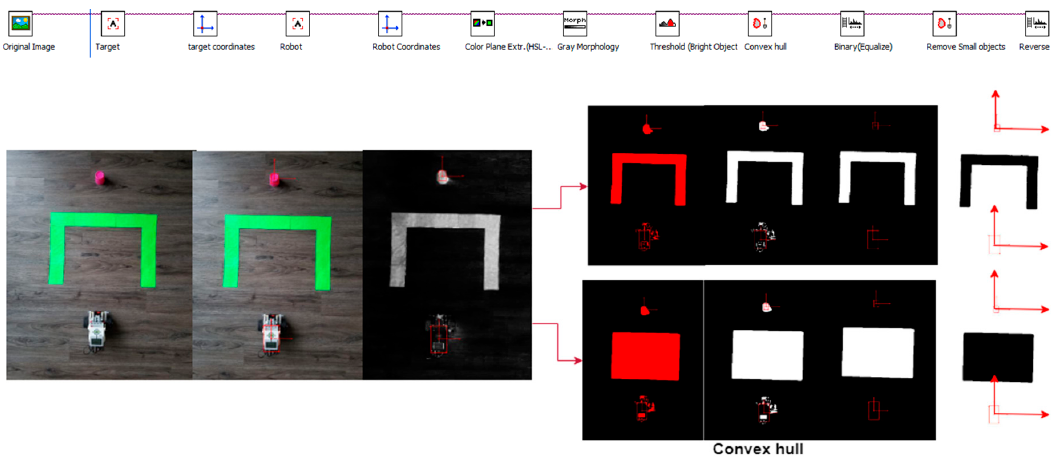
Figure 8. Structure and functionality of vision algorithm (first scenario).